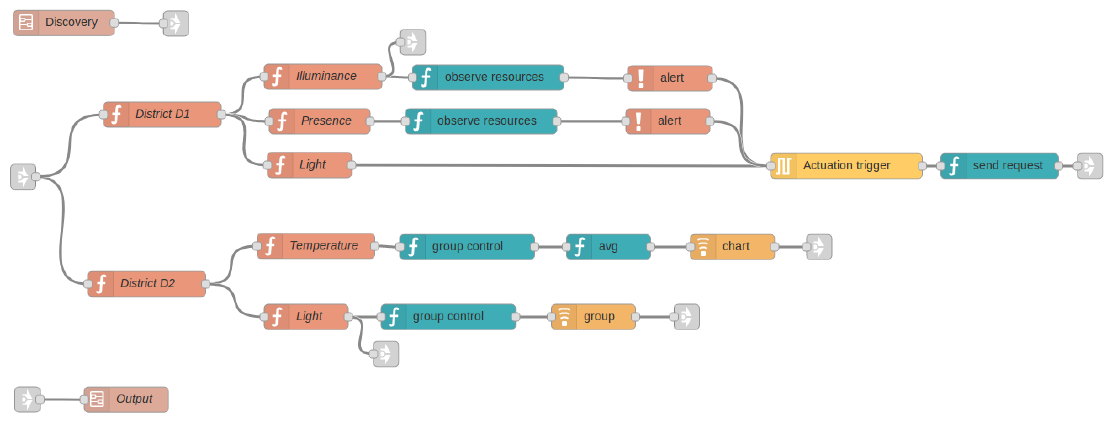
Figure 12. Smart-city use case translated into a Appdaptivity